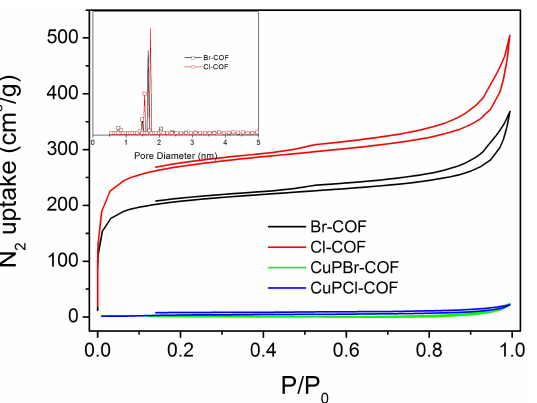
Figure 7. N 2 adsorption/desorption isotherms of CuPX-COF and X-COF, X = Br, Cl. Inset: pore distribution of